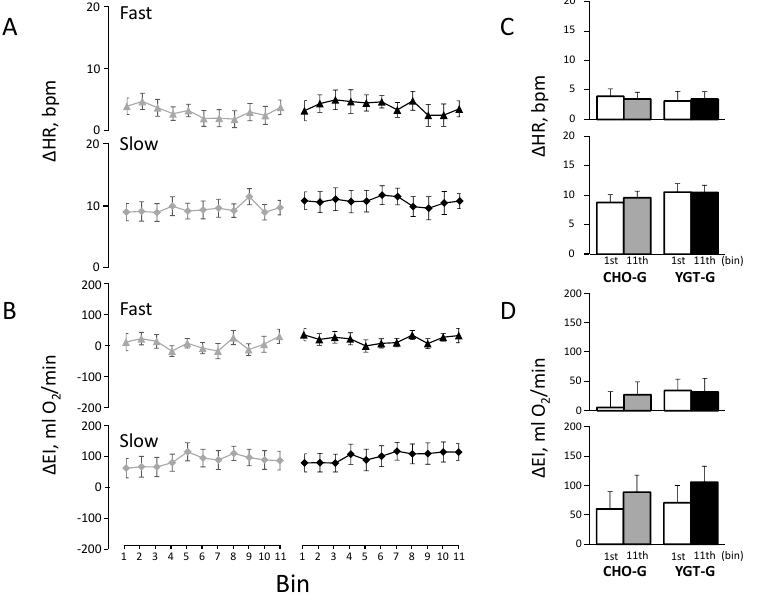
Figure 5. The profiles of the differences in heart rate ( ∆ HR) ( A ) and exercise intensity ( ∆ EI) ( B ) between the first and last sets of IWT throughout the intervention in both groups. The comparison of ∆ HR ∆ HR fast and slow between the 1st and 11th bins are presented in the upper and lower panels, respectively ( C ). Similarly, the comparison of ∆ EI fast and ∆ EI slow between the 1st and 11th bins are presented in the upper and lower panels, respectively ( D ). The symbols and other abbreviation are the same as in Figure